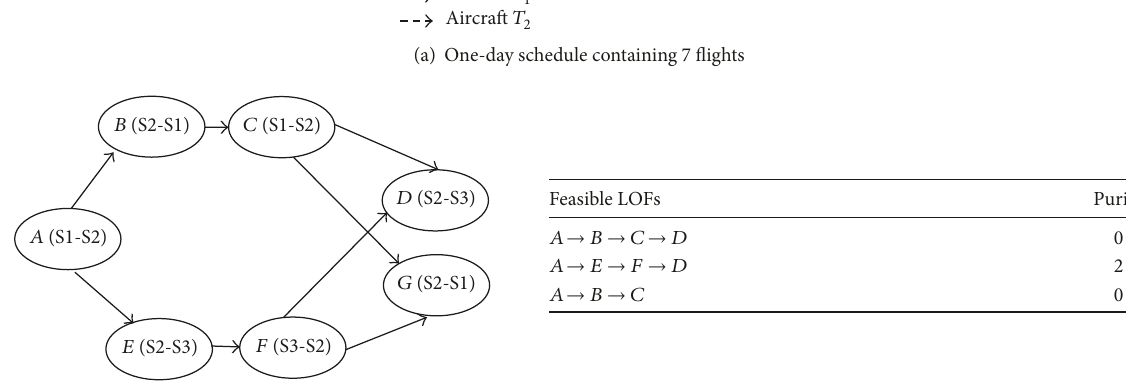
from or stayed at the station after the time. The constraints in (8)-(9) determine whether or not the airport violates the terminal balance. The constraints in (10) are binary variable